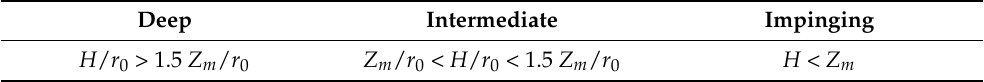
Table 2. Flow regime in shallow vertical dense jet discharges [11]. Deep Intermediate